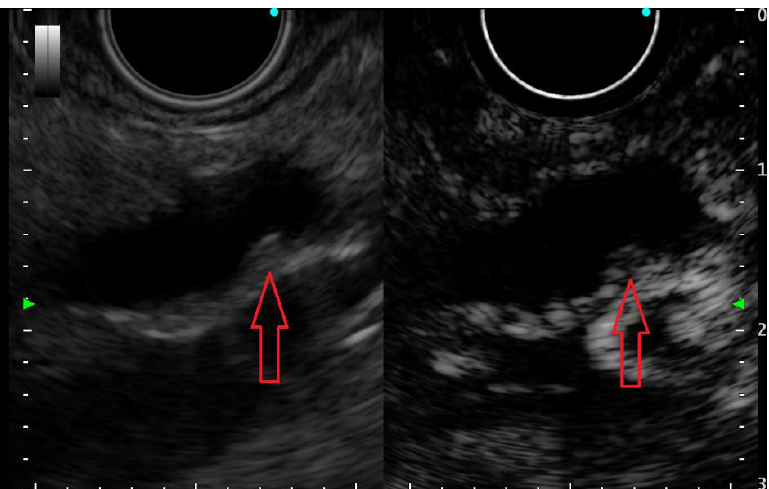
Figure 2. Small (3 mm) mural nodule (red arrow) in a pancreatic cyst — presumably an IPMN, appearing hyperenhanced on contrast-enhanced EUS examination; thus, it is undoubtedly a true mural nodule.